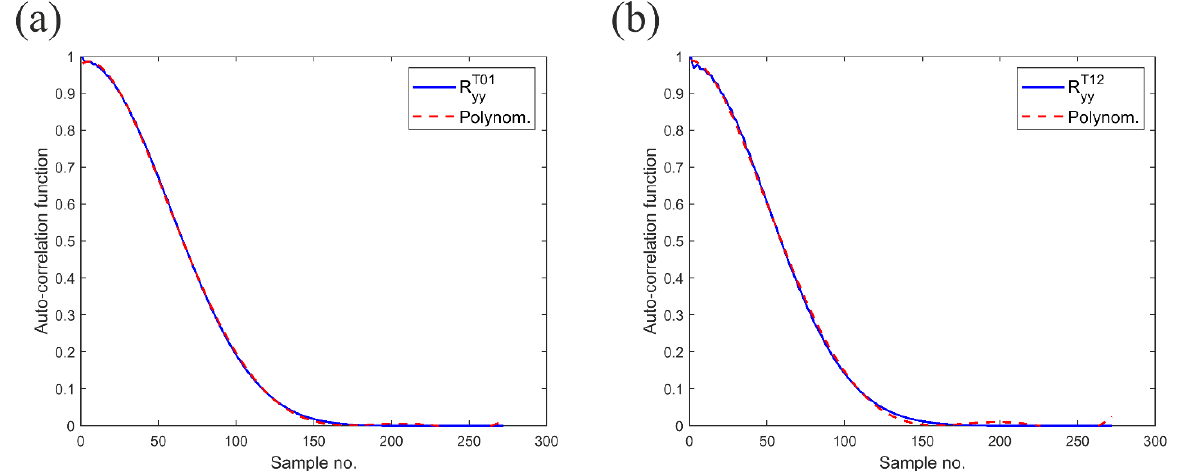
Figure 7. Auto-correlation signal for the rotor supported on the SKF 1207K bearing (with the ball cut on a depth of 1 mm) with the matching curve: ( a ) during the observation period T 01 ; ( b ) during the observation period T